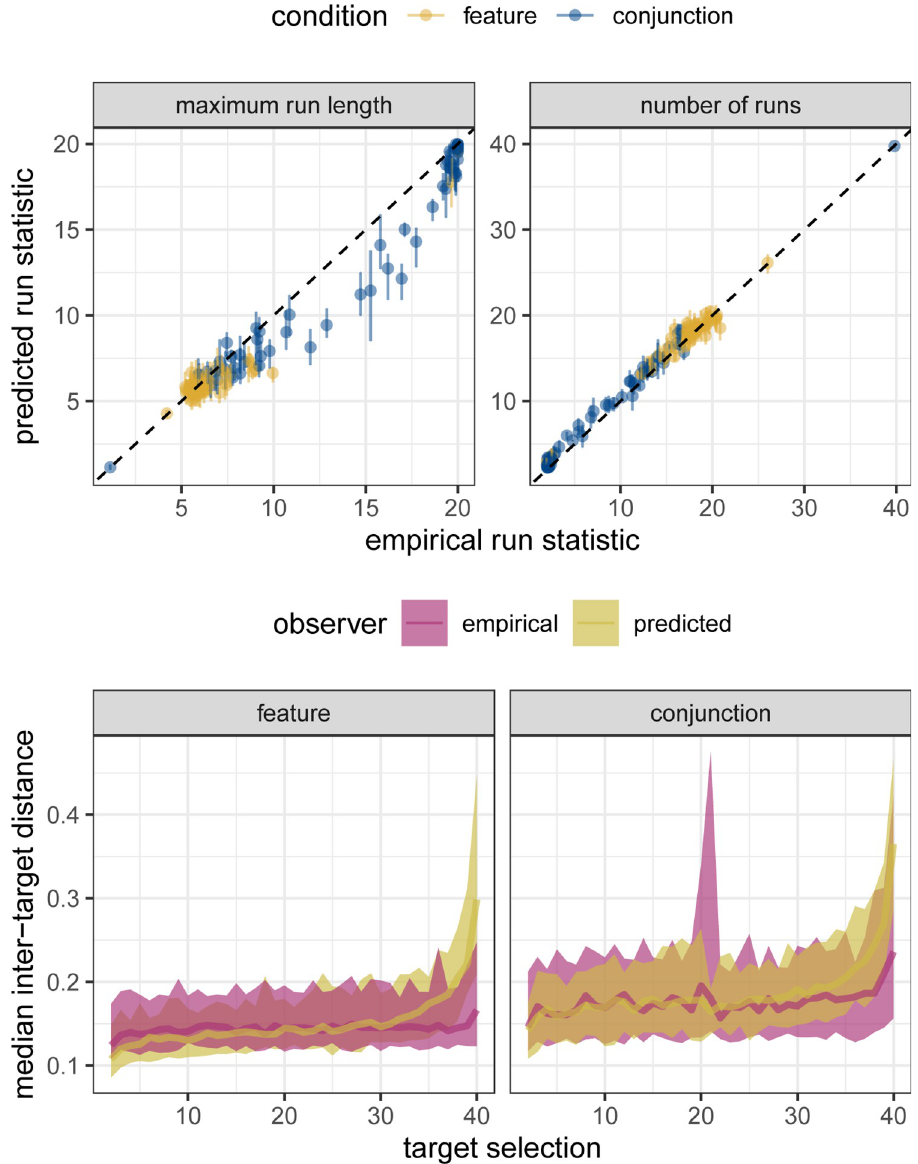
Fig 9. Posterior predictions for Clarke et al. (2018). ( top :) Scatter plots between empirical and predicted summary run statistics. Error bars indicated 89% HPDI for the posterior predictions. ( bottom :) Comparison of inter-target distances and how they vary over time. Shaded region gives 89%